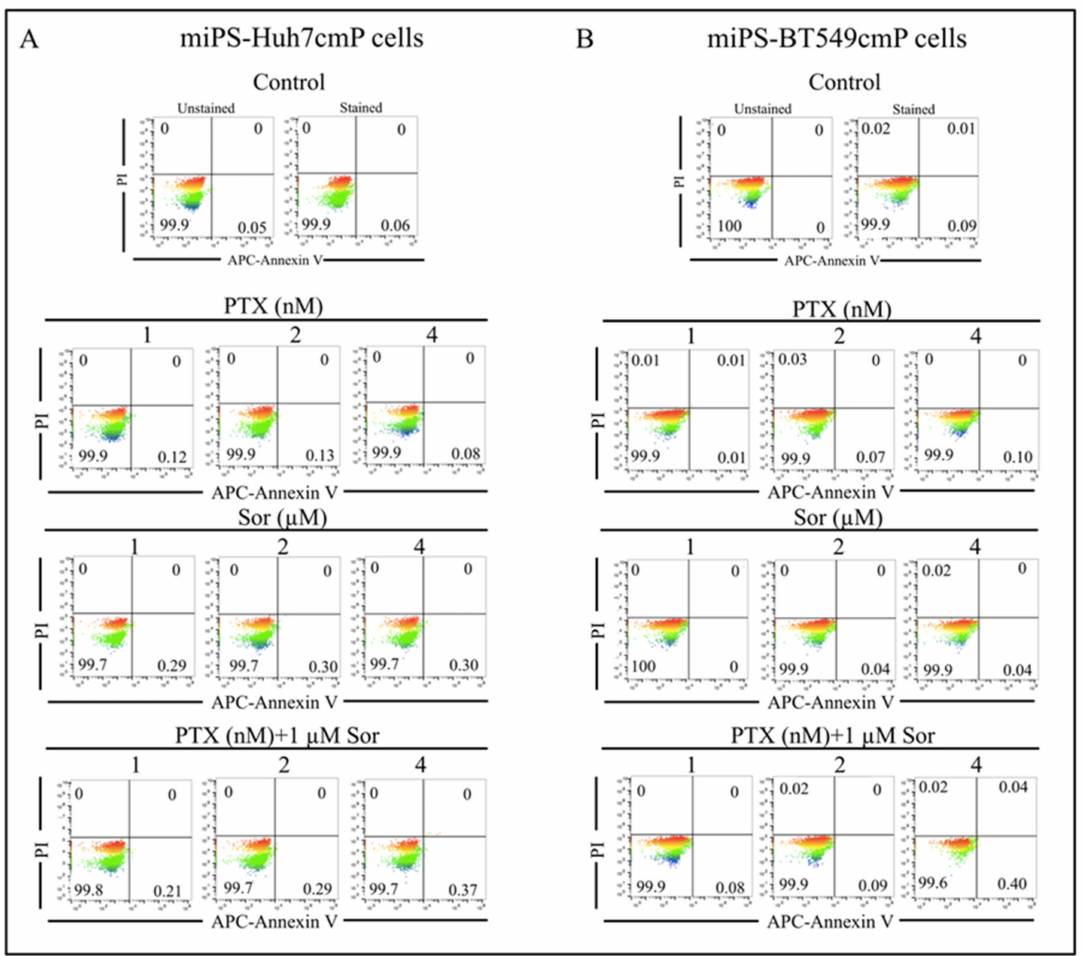
Figure 2. Annexin V-APC / PI double staining flowcytometric analysis of apoptosis in miPS-Huh7cmP ( A